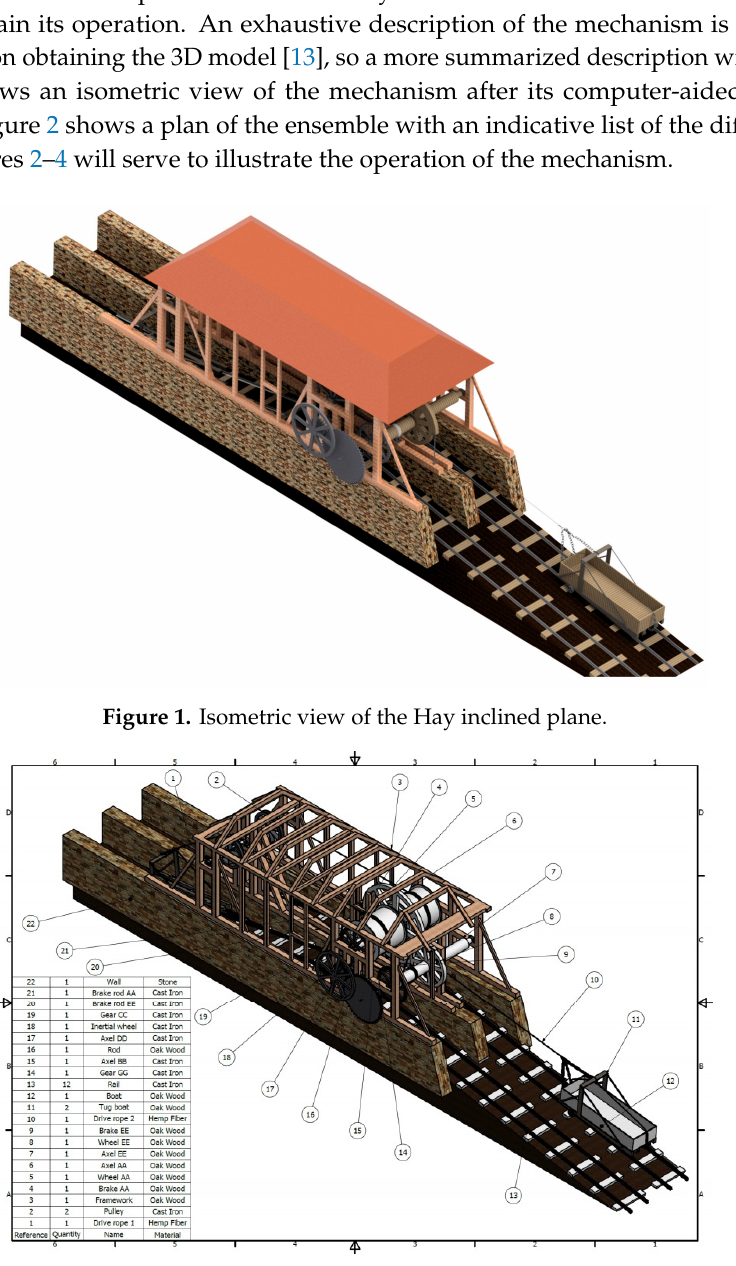
Figure 2. Plan of the ensemble with an indicative list of the different elements.